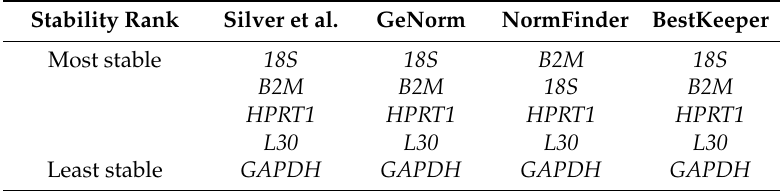
Table 2. Four different methods were used to rank five common reference genes according to their